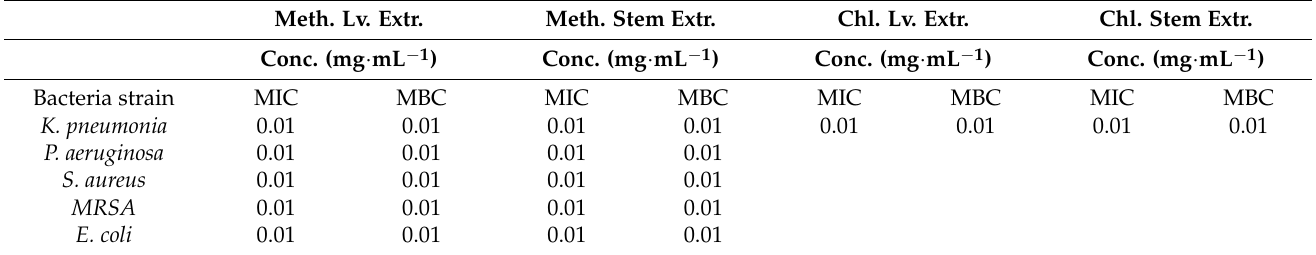
Table 10. Minimum inhibitory concentration (MIC) and minimum bactericidal concentration (MBC) of D. villosa leaf and stem-bark extracts against different bacterial strains. Meth. Lv. Extr. Meth. Stem Extr. Chl. Lv. Extr. Chl. Stem Extr.